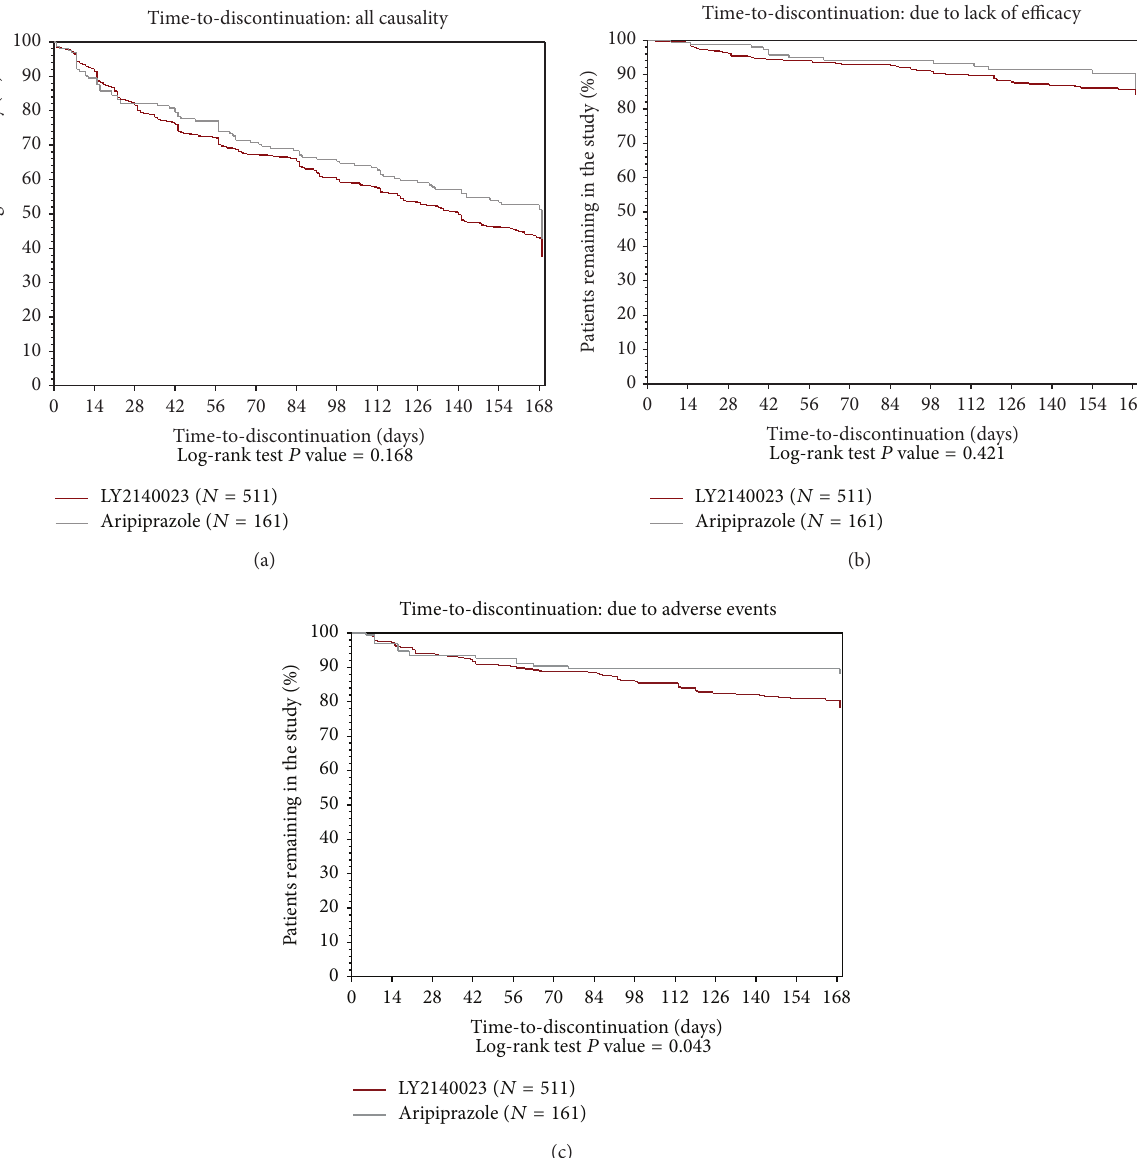
Figure 2: Kaplan-Meier plots showing time-to-discontinuation (all causality, due to lack of efficacy, and due to adverse events) for intent-to- treat (ITT) patients with schizophrenia in pomaglumetad methionil ( 𝑁 = 511 ) and aripiprazole ( 𝑁 = 161 ) treatment groups for 24 weeks of double-blind